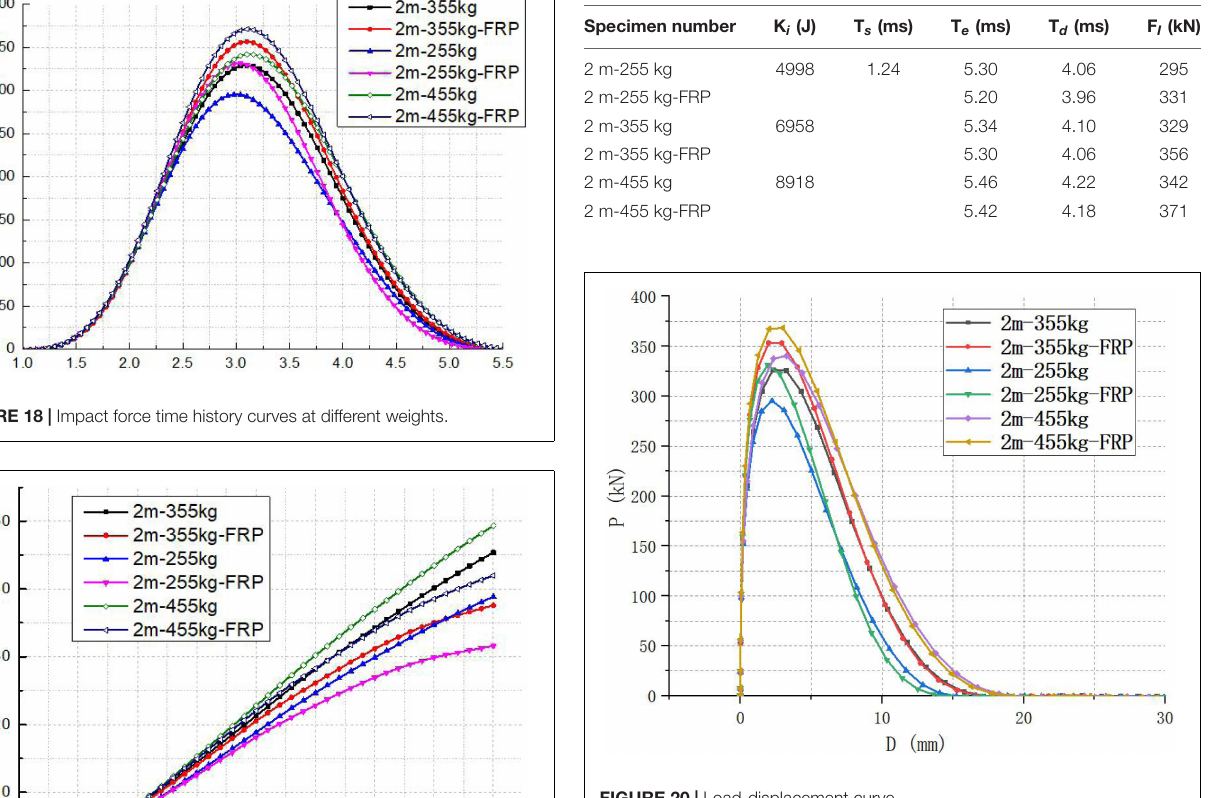
FIGURE 20 | Load-displacement